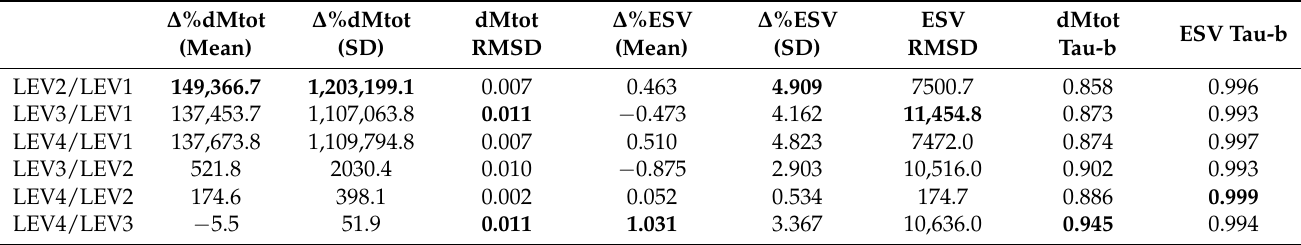
Table 3. Comparison between couples of scenarios at the Non-Urbanized Area (NUA) level. Bold numbers represent maximum values.